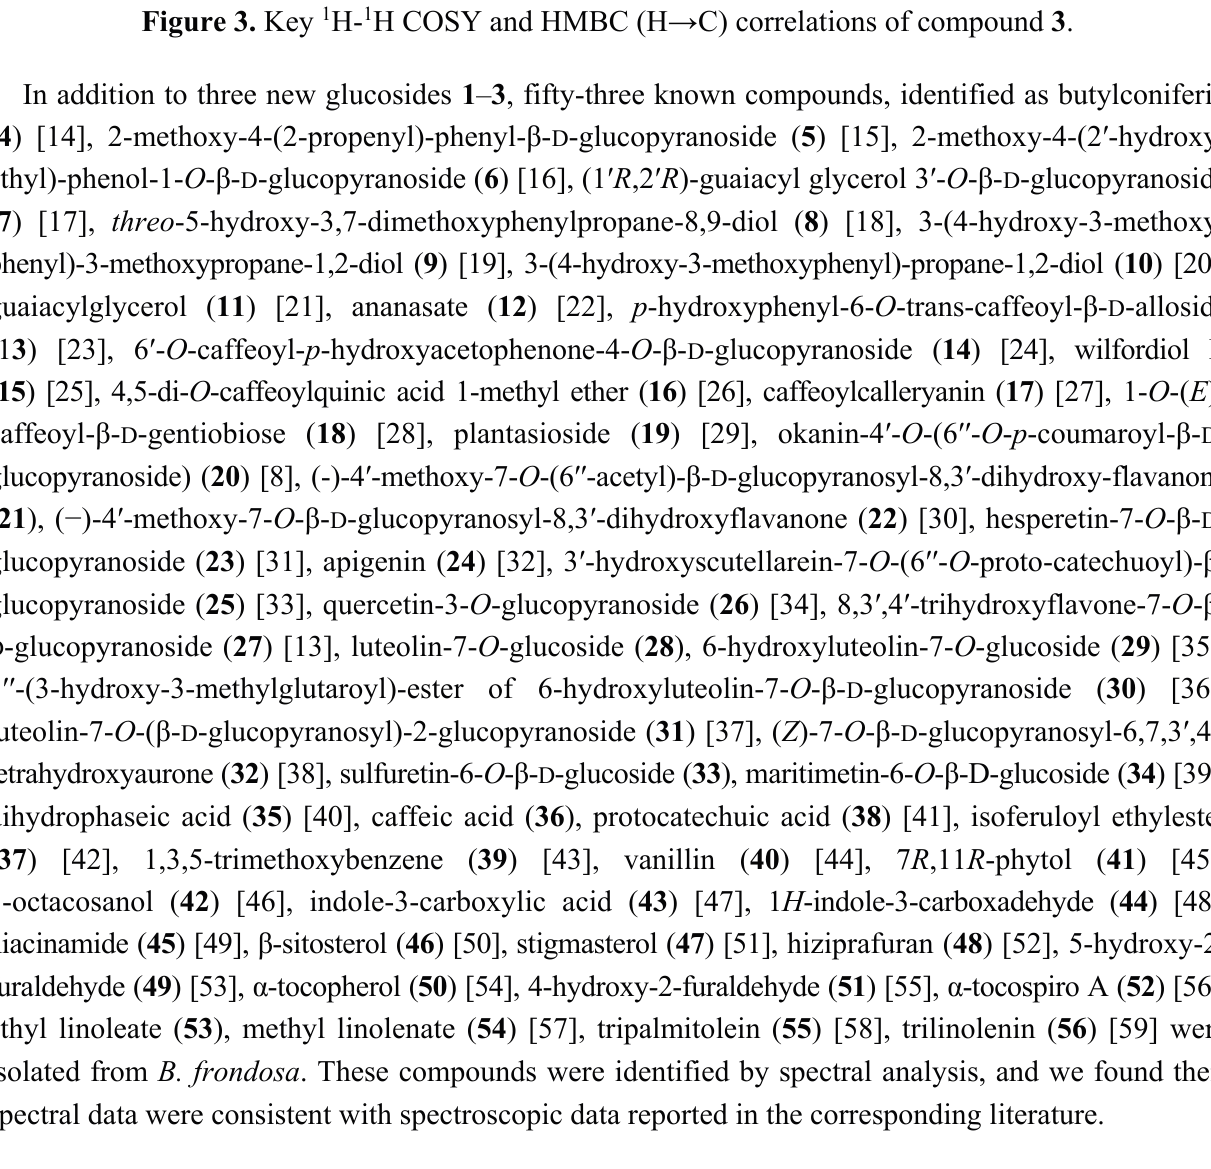
Figure 3. Key 1 H- 1 H COSY and HMBC (H → C) correlations of compound 3